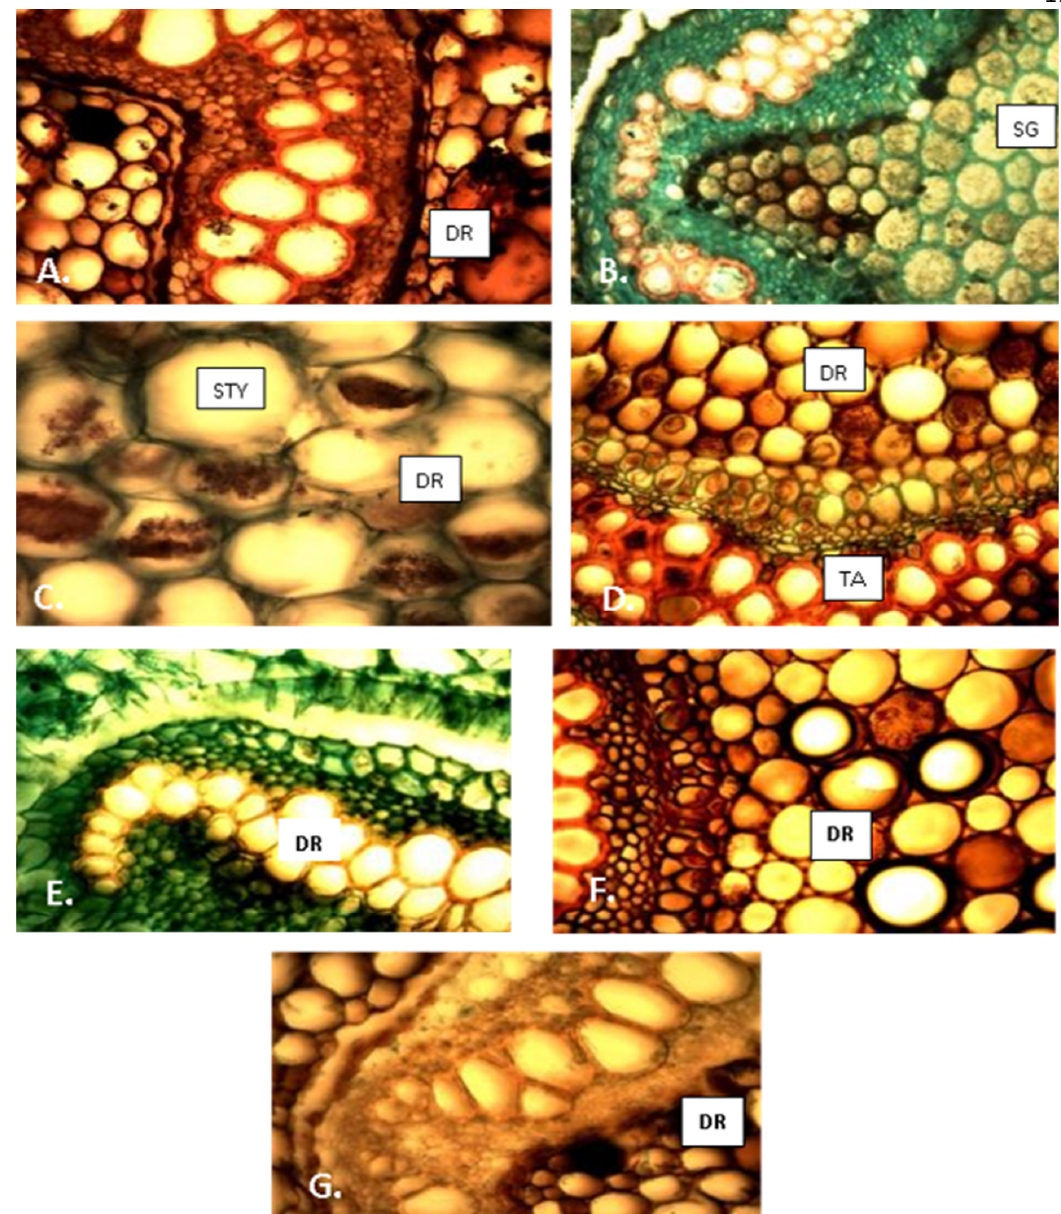
Figure 7. Ergastic substance in proximal stipe regions of Pteris species. A: Druses in xylem of P. acanthoneura, B: Starch granules in parenchyma of P. atrovirens ; C: Styloids in xylem of P. ensiformis ; D: Tannis and druses in parenchyma of P. mildbraedii , E: Druses in phloem of P similis , F: Druses in phloem and parenchyma cells in P. togoensis, G :Druses in phloem of P.